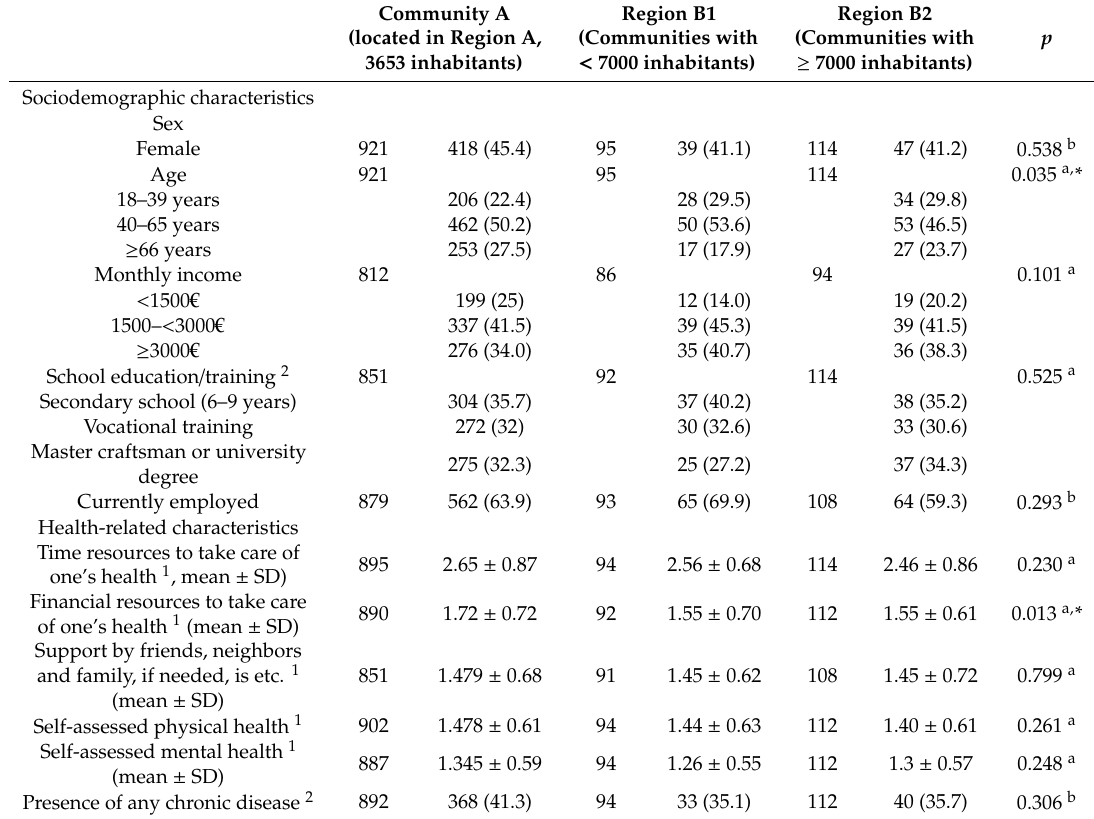
Table 2. Characteristics of the study population by region /